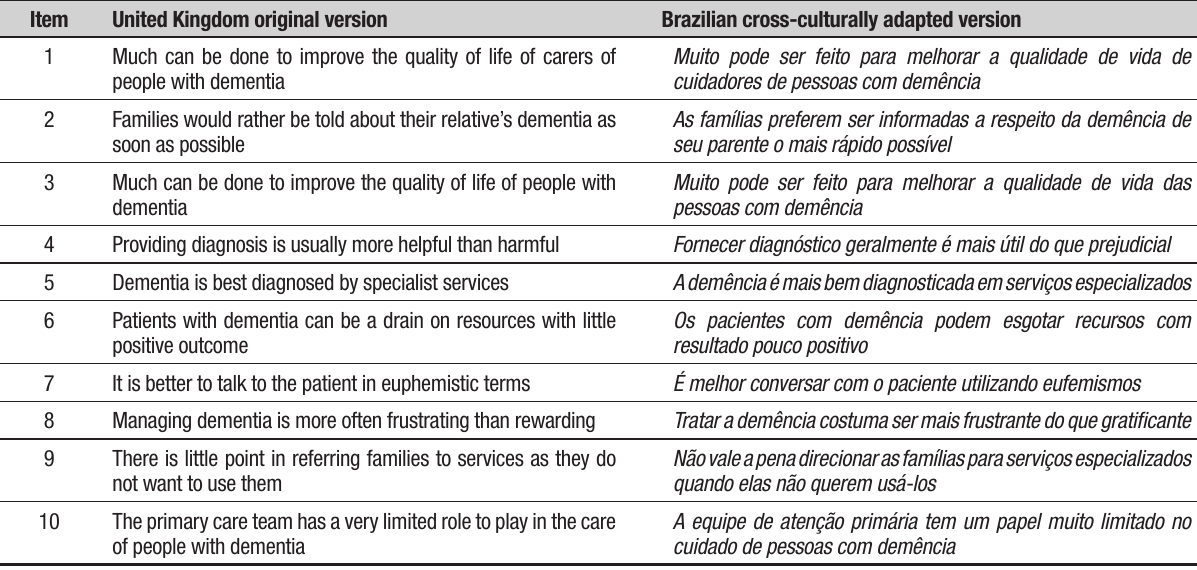
Table 2. “Attitude Quiz” of physicians toward dementia.